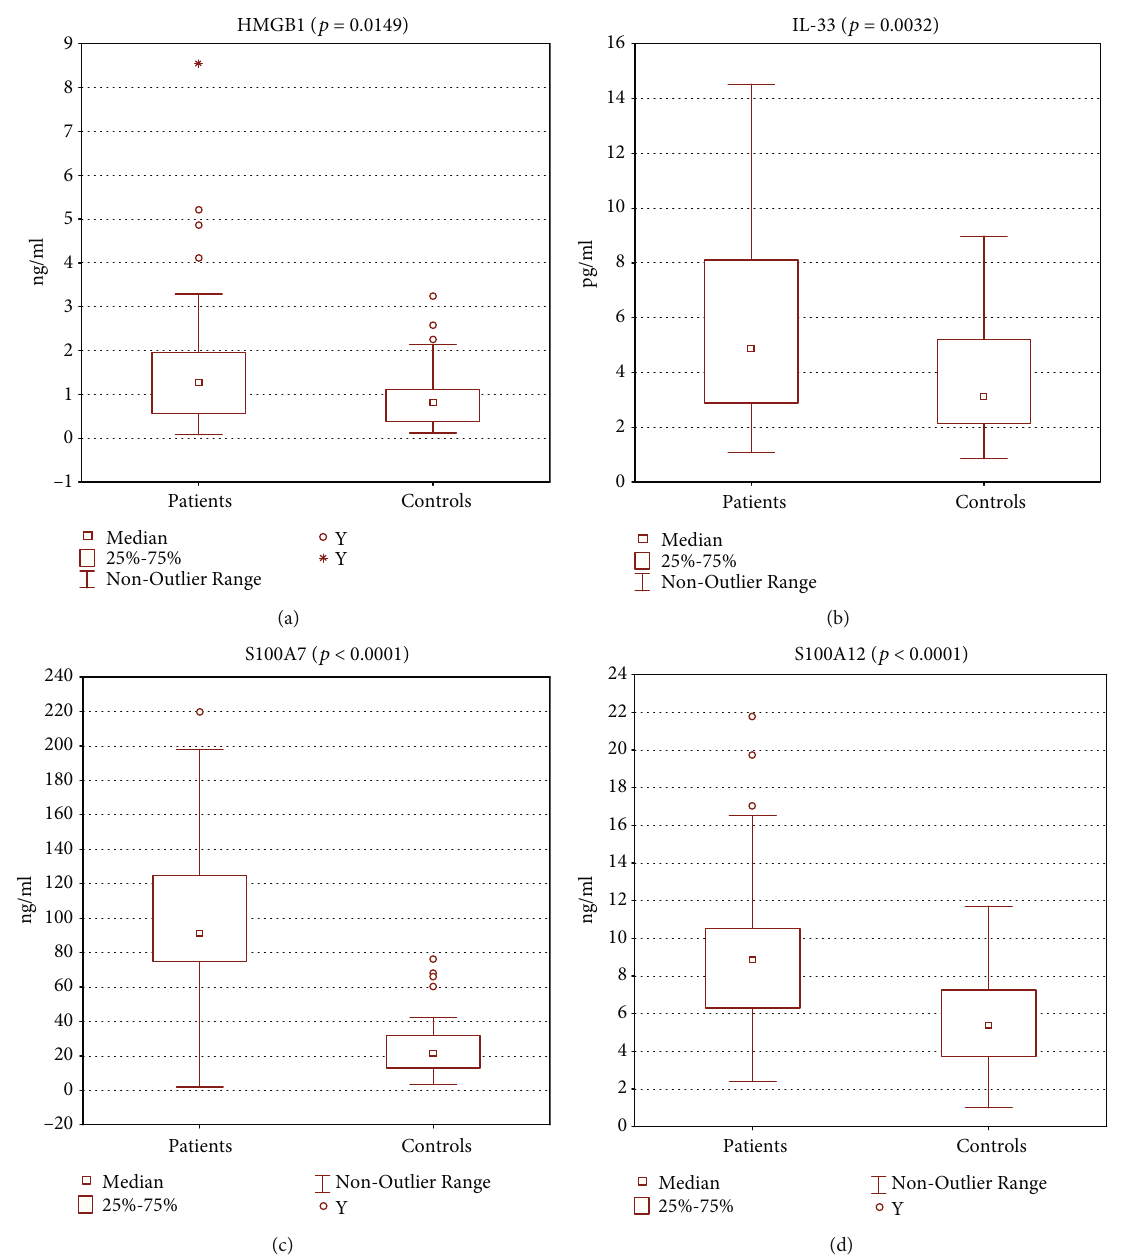
Figure 1: All the measured parameters were elevated in the group of patients when compared to healthy controls. (a) High Mobility Group Box 1 (HMGB1; patients, N = 51 , median 1.250; controls, N = 35 , median 0.810; p < 0 : 05 , Mann – Whitney test). (b) IL-33 (patients, N = 51 , median 4.890; controls, N = 35 , median 3.110; p < 0 : 01 , Student ’ s t -test). (c) S100A7 (patients, N = 63 , median 91.0; controls, N = 60 ; median 21.7; p < 0 : 0001 , Mann – Whitney test). (d) S100A12 (patients, N = 63 , median 8.80; controls, N = 60 ; median: 5.40; p < 0 : 0001 , Mann – Whitney